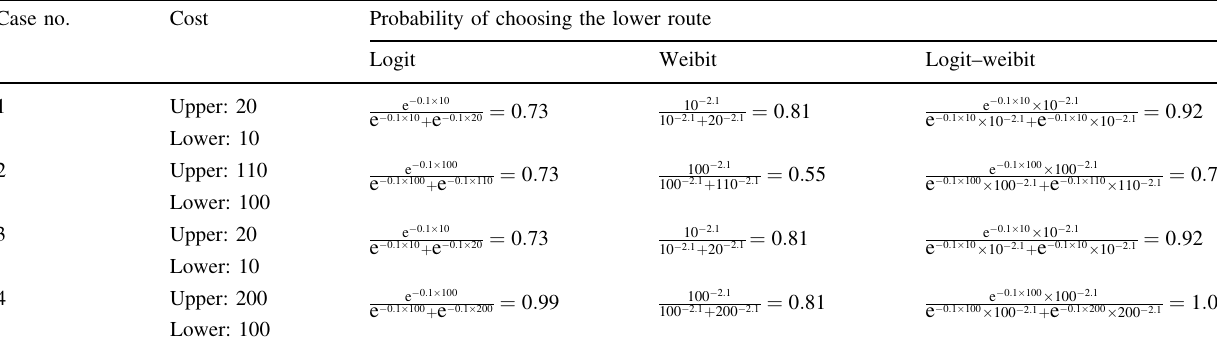
Table 1 Comparison of route choice probability of the logit, weibit, and hybrid models Case